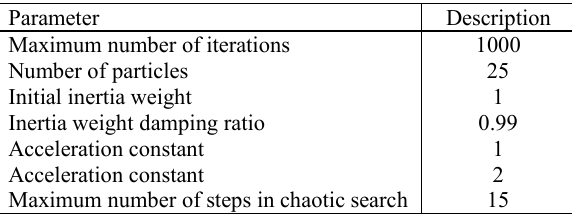
Table 5. Parameters for